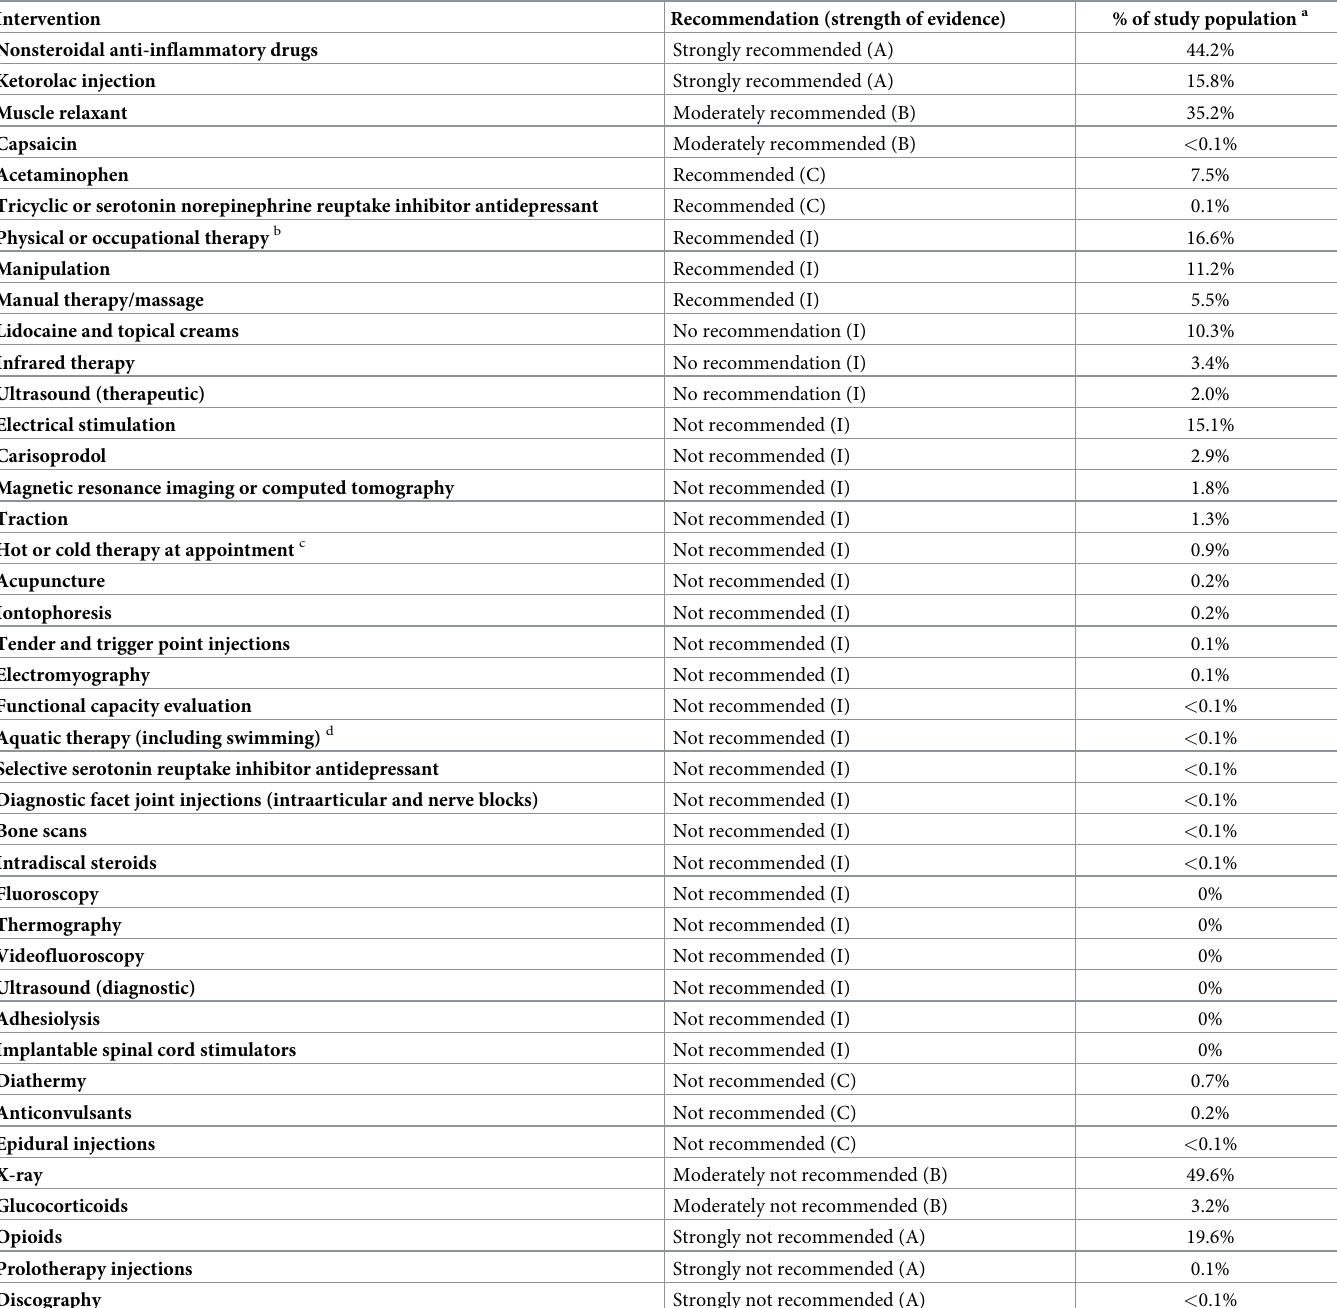
Table 2. Frequency of interventions for acute low back pain in first week of